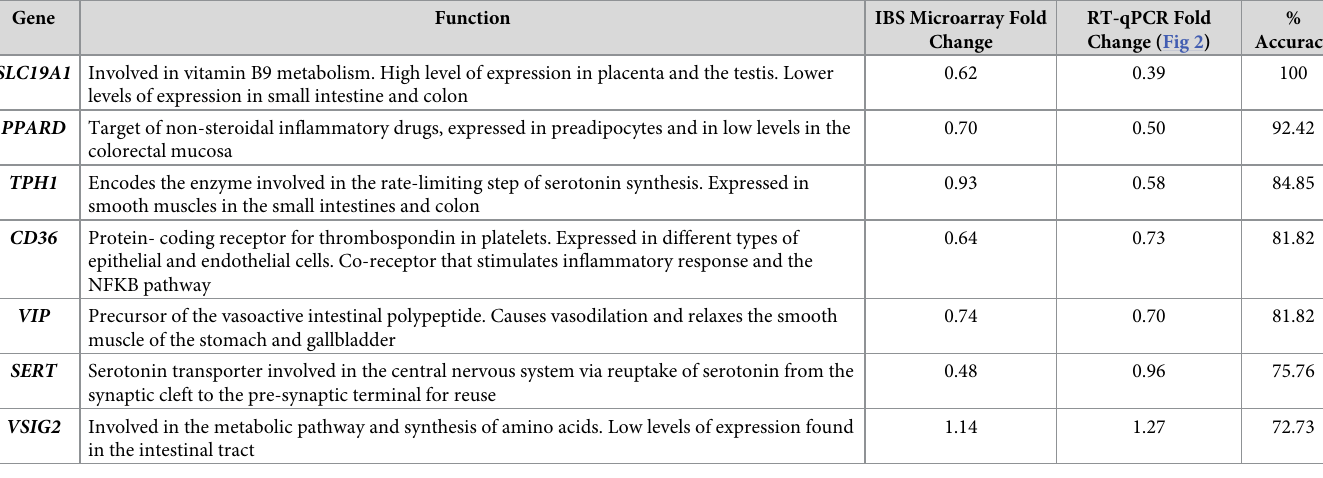
Table 2. Putative IBS biomarker genes with calculated accuracy using DNA microarray and RT-qPCR as a validation tool.